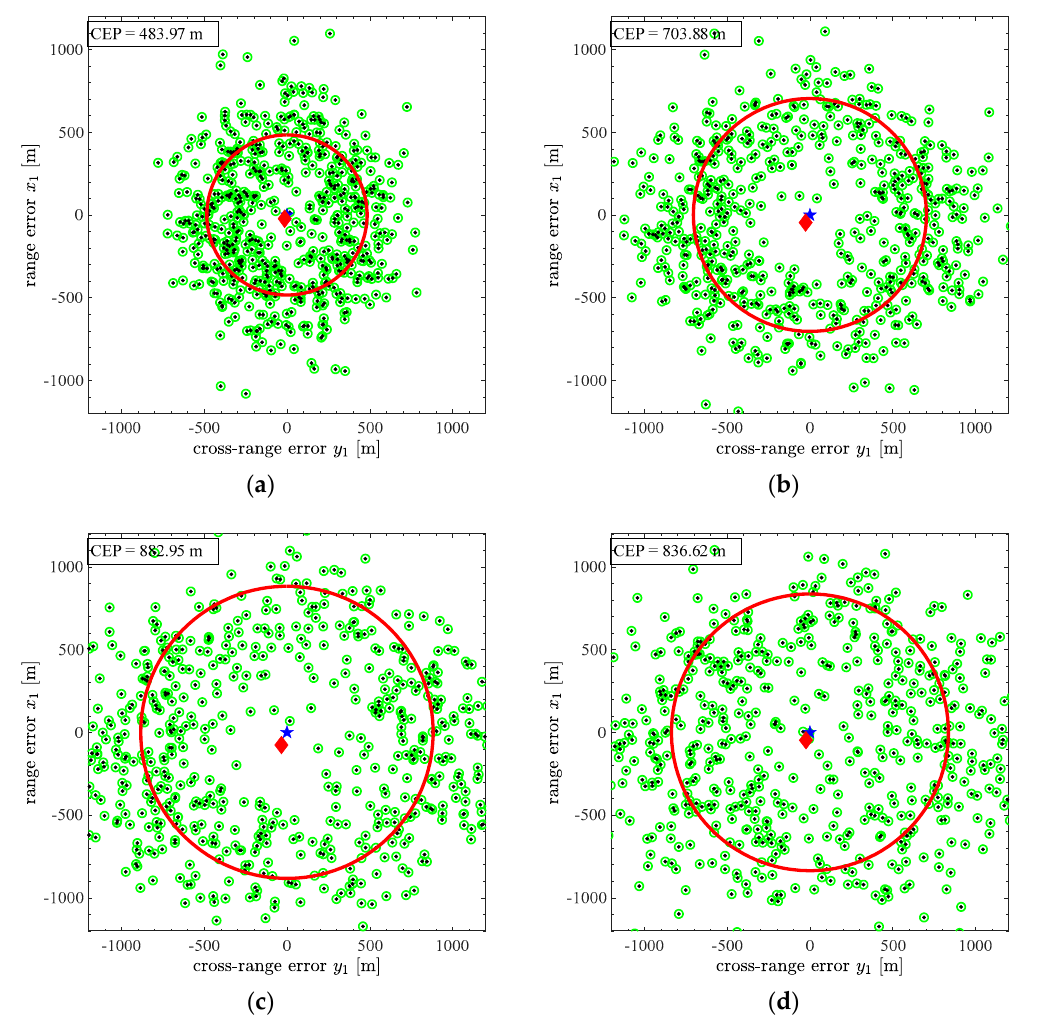
Figure 15. The projectile footprint for various nominal launch elevation angles ( a ) Θ 0 = 20 ◦ ( b ) Θ 0 = 30 ◦